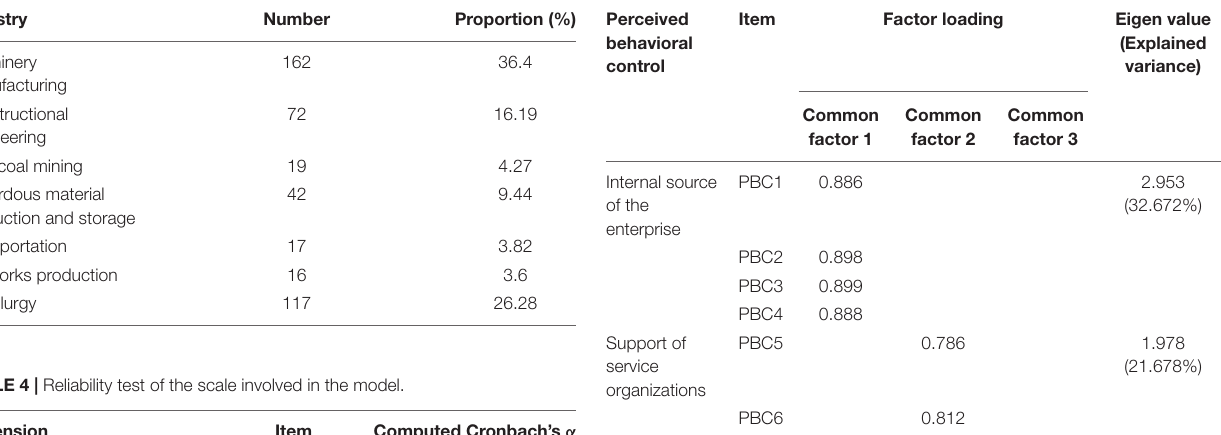
TABLE 5 | EFA results of the perceived behavioral control.